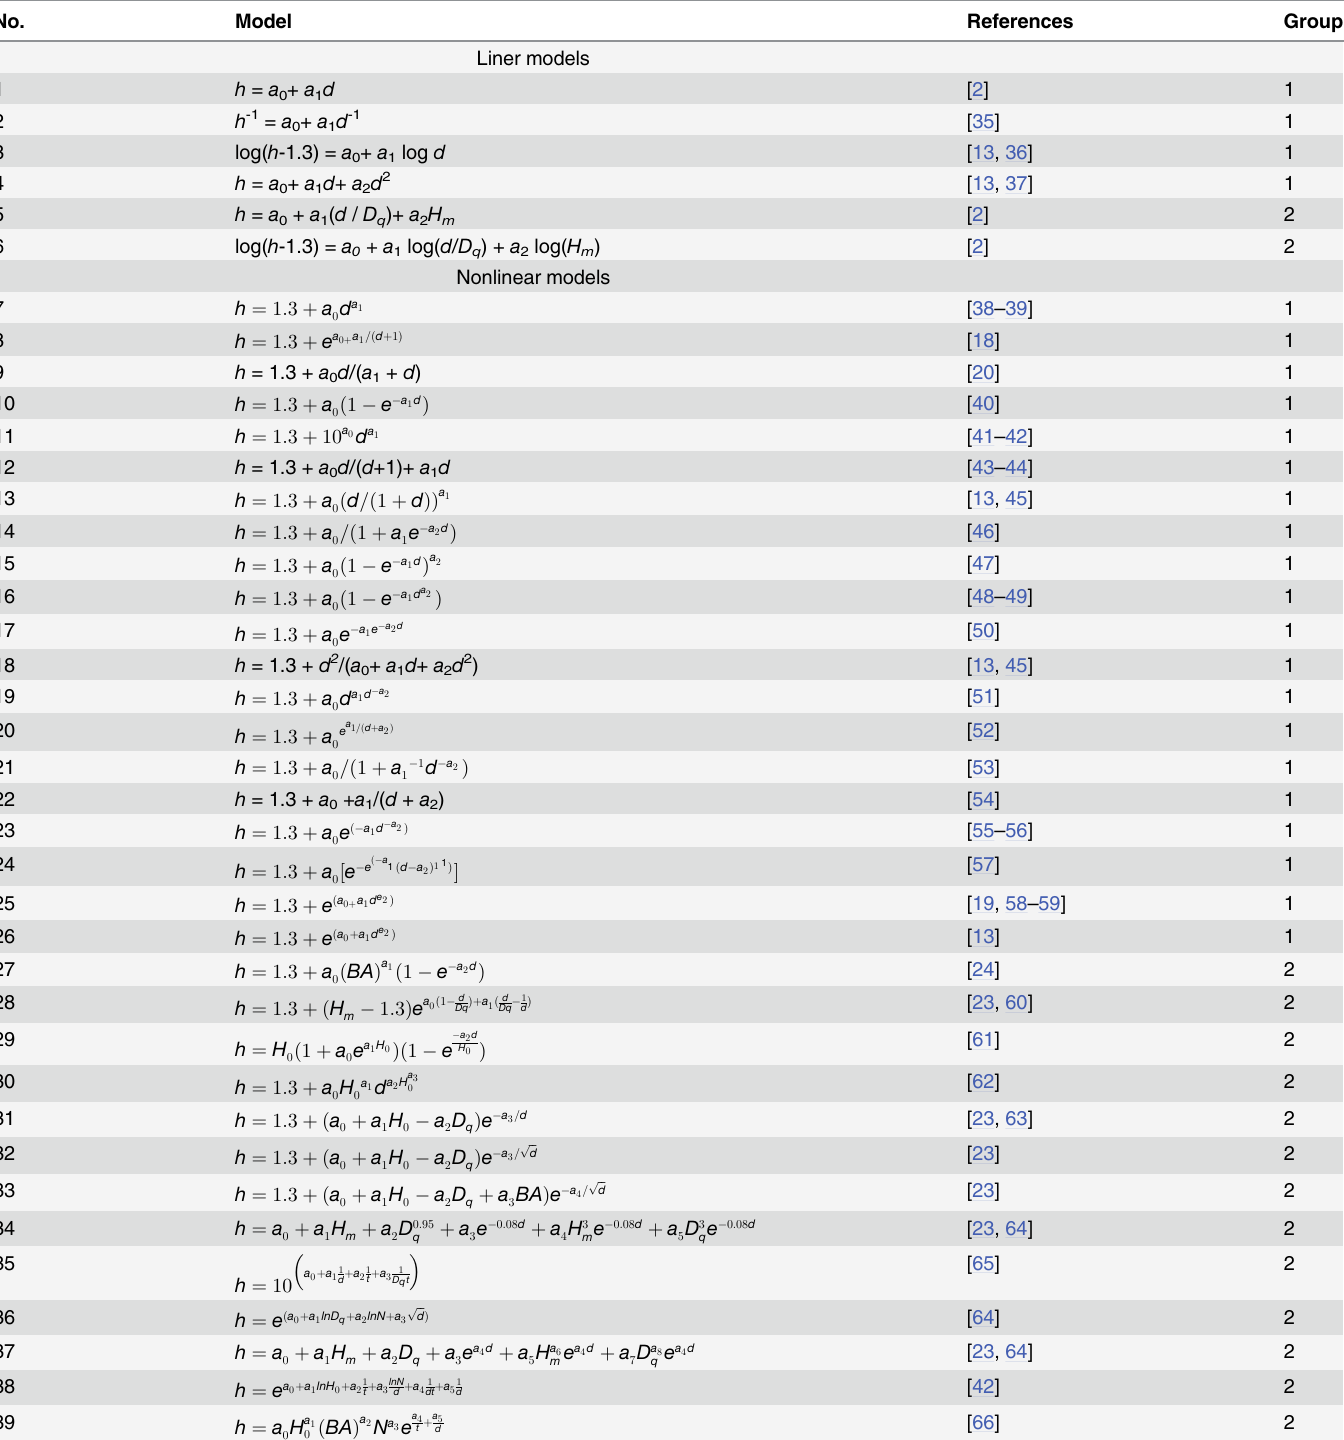
Table 2. Height-dbh models selected for